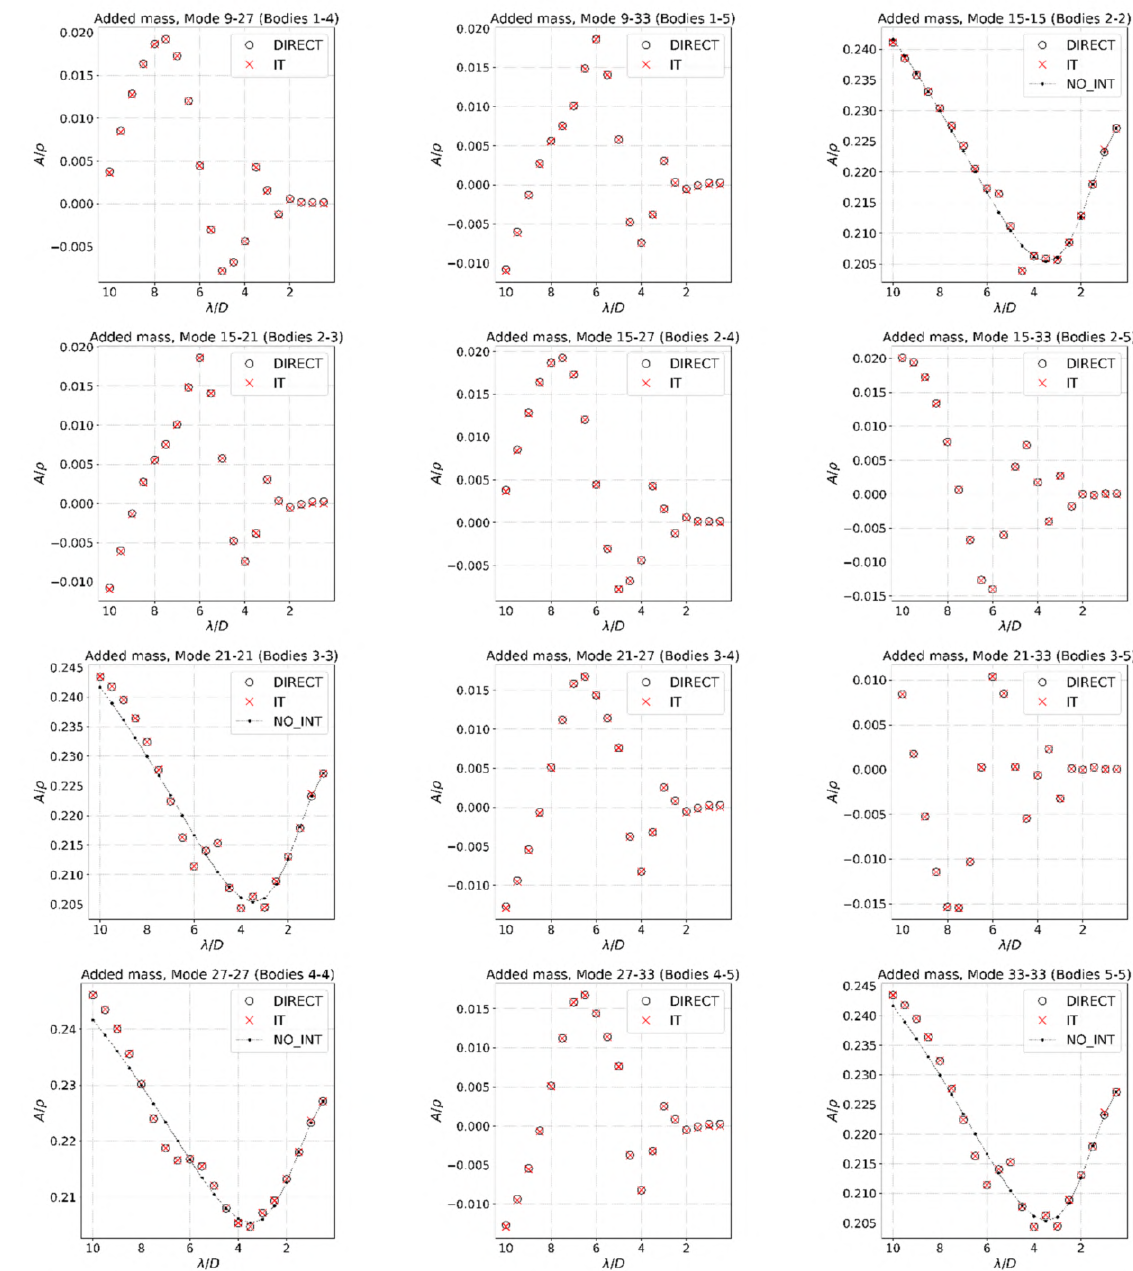
Figure 6. Added mass coefficients for heave motion. “DIRECT”, “IT”, and “NO_INT” denote the solution using WAMIT with the direct method, the solution using the interaction theory, and the solution for a single isolated body using the direct method and body W 1 , respectively. A denotes the added mass and ρ stands for the fluid density.